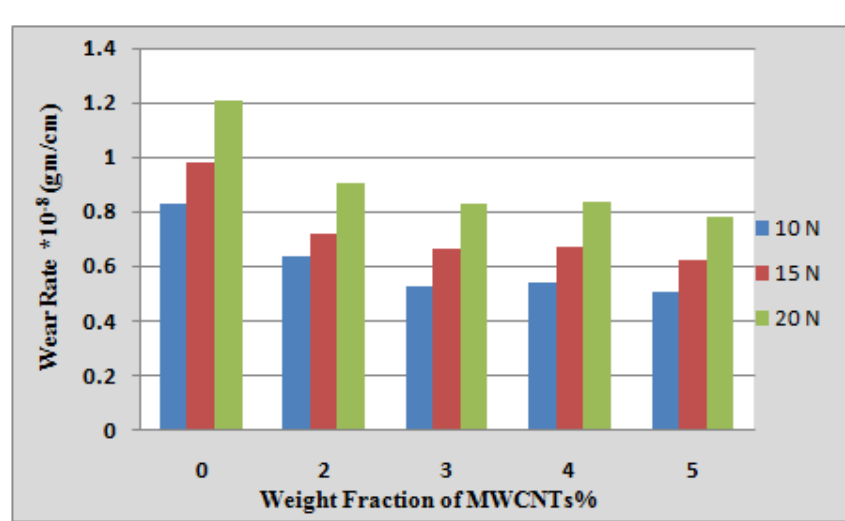
Fig. 5: The relation between the wear rate and weight fraction of MWCNTs in natural